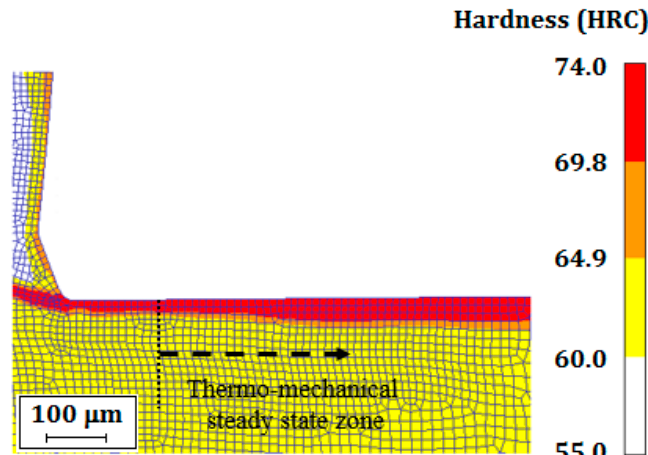
Figure 7. Hardness prediction: NH-W / V = 91 m / min (NH-W: negative rake worn insert).